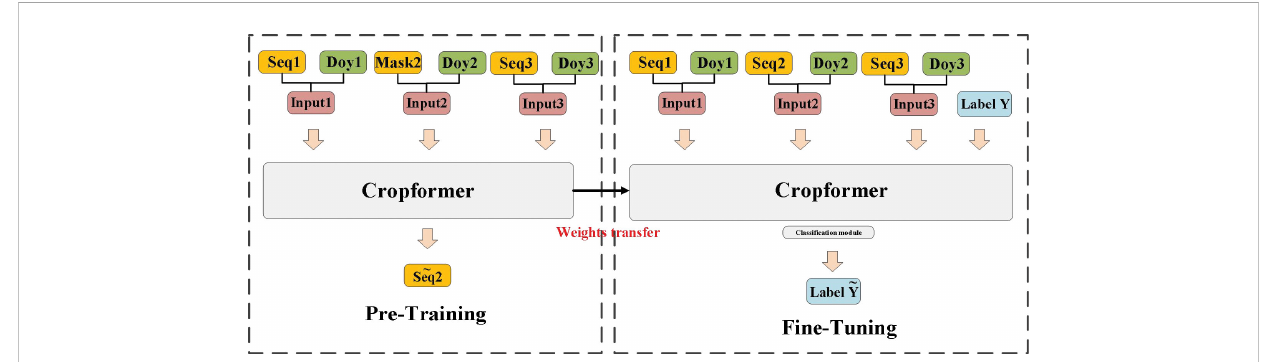
FIGURE 5 Cropformer crop classi fi cation framework. Seq represents the input time series, Mask represents the time series being masked, and Doy represents the sampling time point. The fi ne-tuning phase has the same network structure as the pre-training phase, but the fi ne-tuning phase has a Classi fi cation